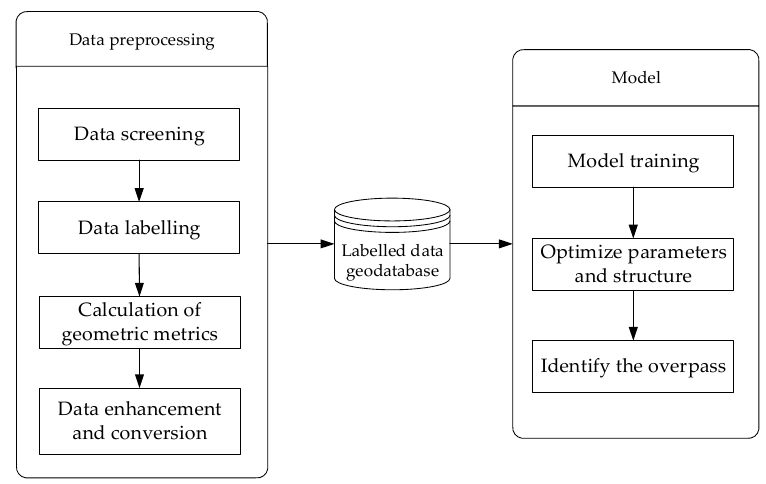
Figure 2 . Technical flow chart . Figure 2. Technical flow chart.